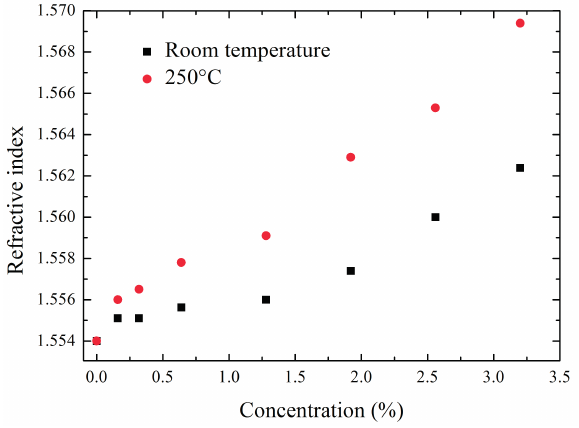
Figure 8. Variation of refractive index at room temperature and after heat-treated at nanoparticles. The accuracy of the refractive index 250 °C in an oven heat-treated 2 h TiO 2 determination is limited by the measuring device to approximately